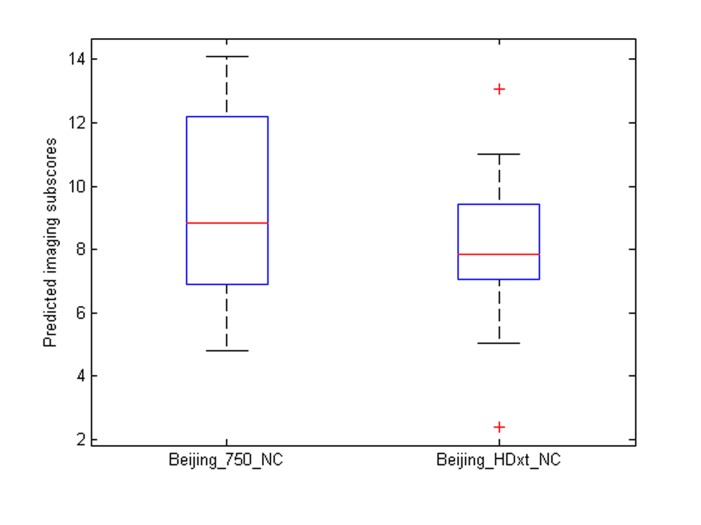
The distribution of the predicted imaging subscores of the healthy controls at different sites.